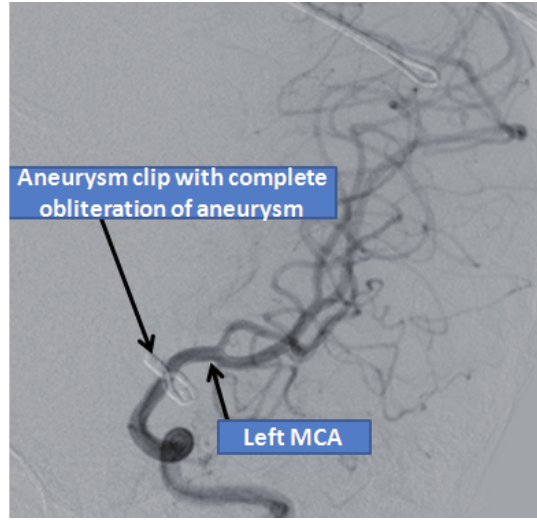
Figure 5. Post-operative angiography showing complete obliteration of the blind aneurysm.